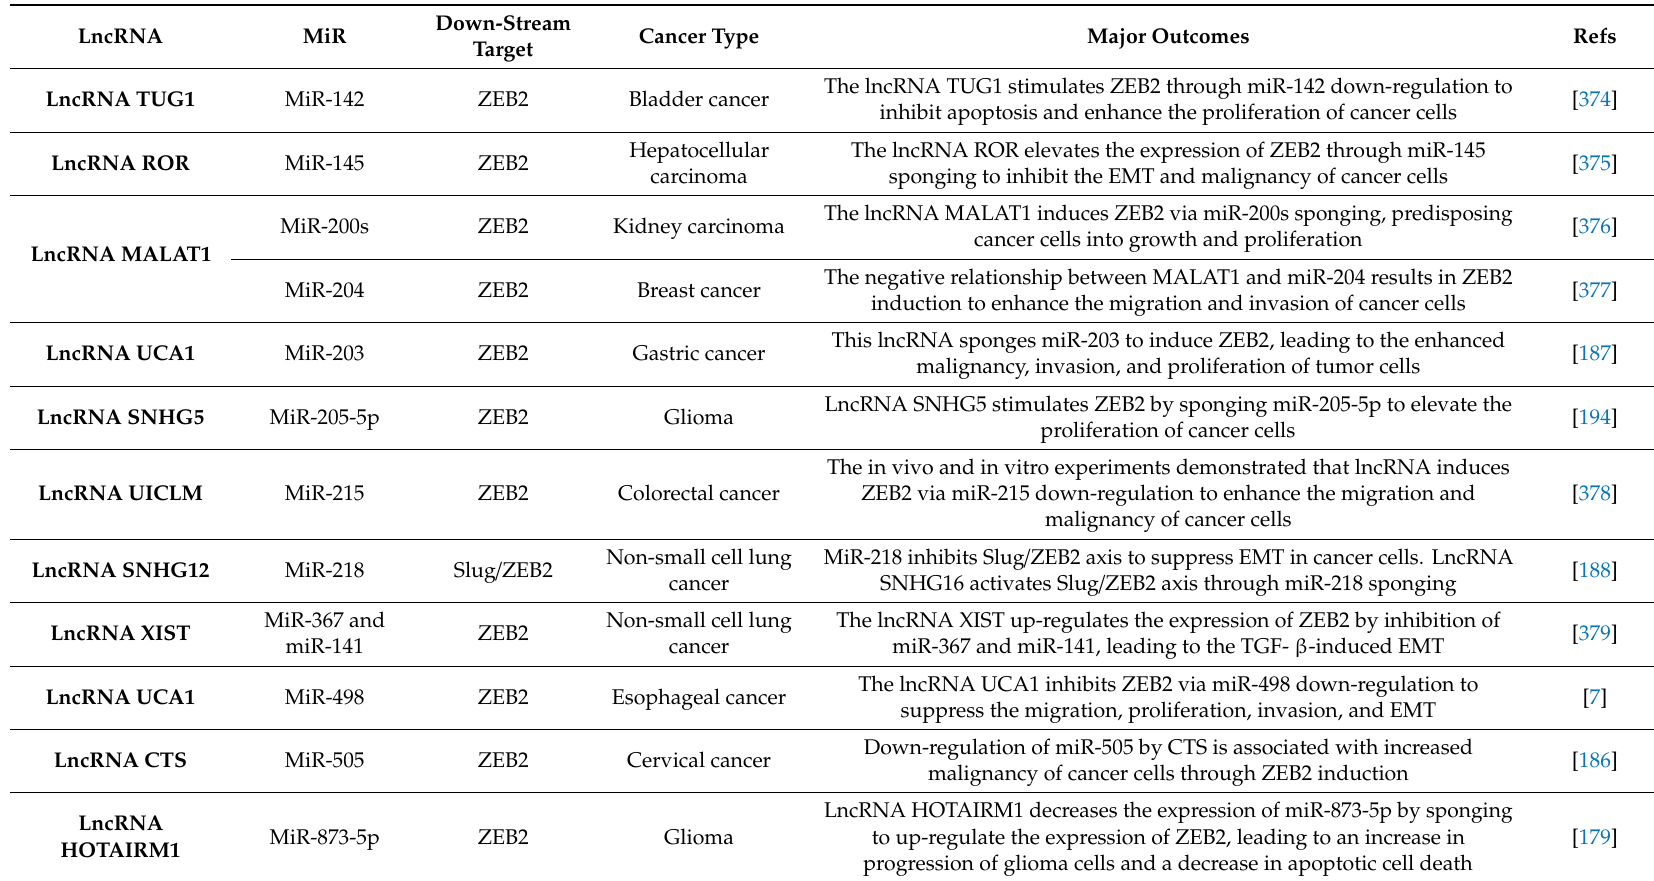
Table 5. MiR / ZEB2 regulation by lncRNAs in di ff erent